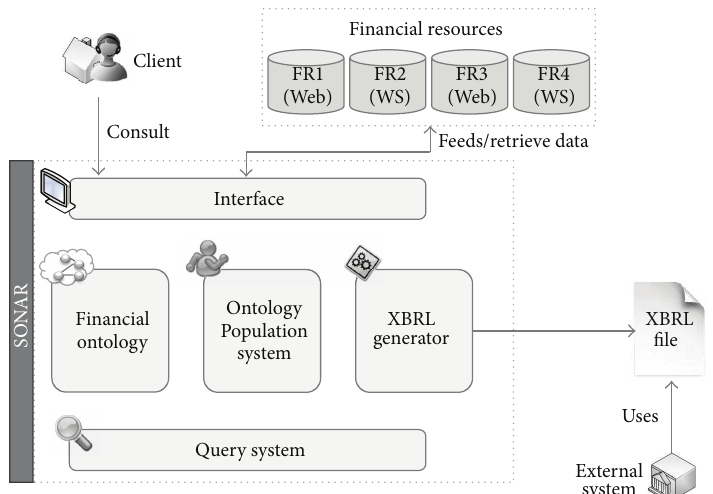
Figure 1: Architecture of the